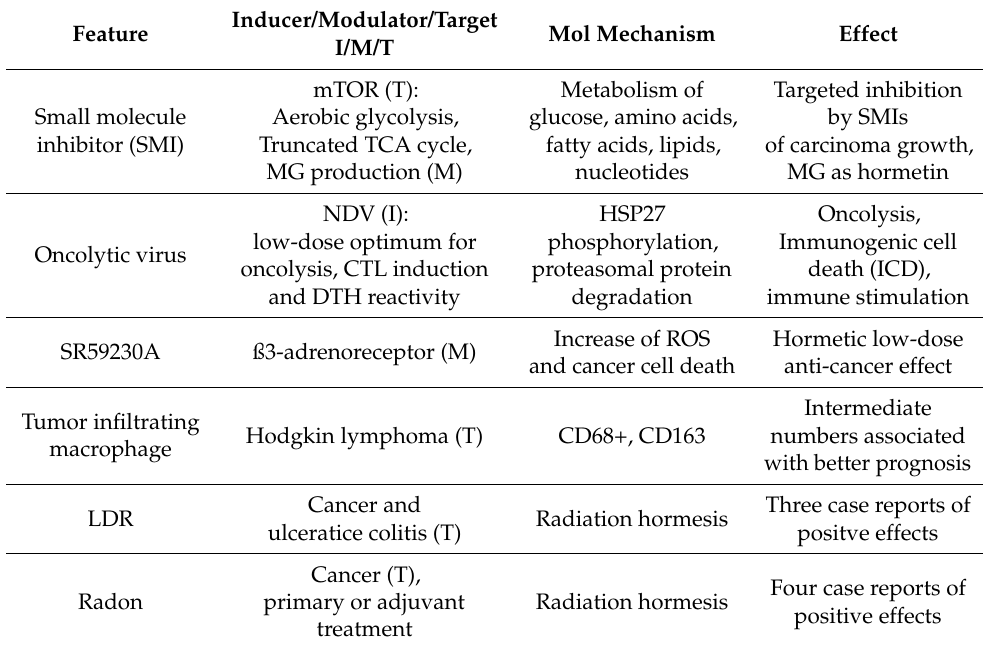
Table 5. Implications for